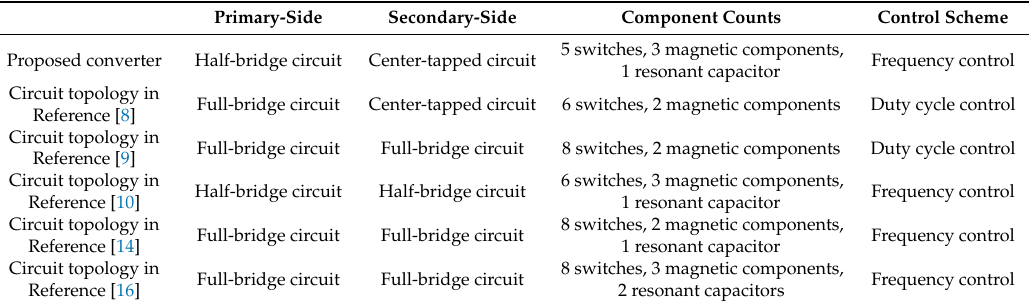
Figure 2. Proposed circuit ( a ) circuit diagram ( b ) forward power transfer ( c ) reverse power transfer. Table 1. Circuit topologies and component counts between the proposed converter and the other bidirectional dc–dc converters.